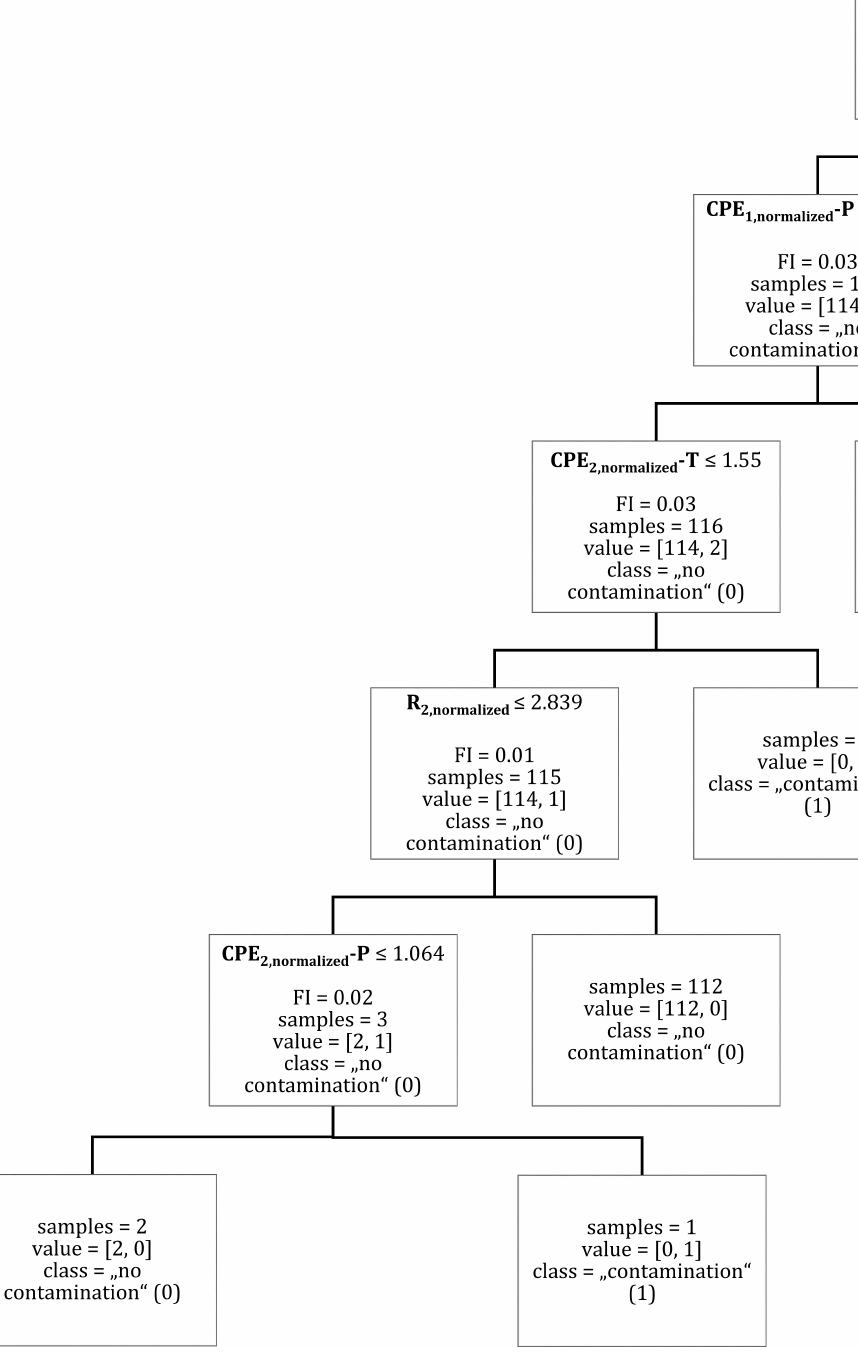
Figure A1. Feature importance (FI) and the classification of data points into the classes “no contamination” (0) and “contamination” (1) for a decision tree without depth limitation. Brackets indicate (“no contamination” (0) and “contamination”